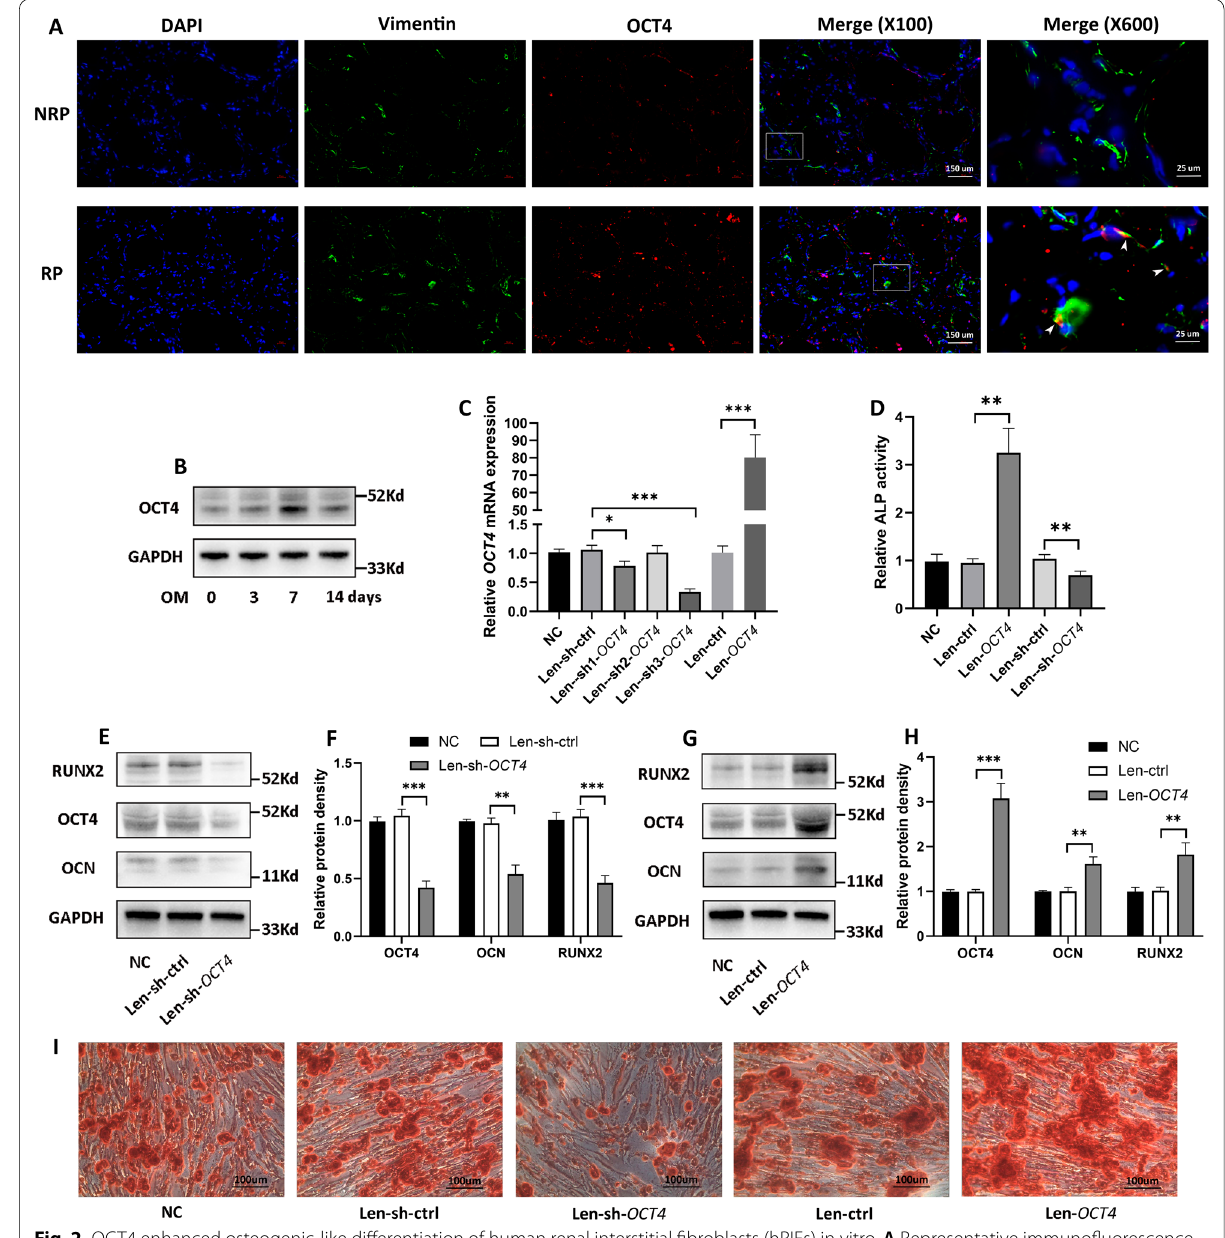
Fig. 2 OCT4 enhanced osteogenic-like differentiation of human renal interstitial fibroblasts (hRIFs) in vitro. A Representative immunofluorescence co-staining images of Vimentin (Green) and OCT4 (Red) in Randall’s plaques (RP; n 6) and normal renal papillae (NRP; n 6). B Immunoblotting (IB) = = analysis of OCT4 in hRIFs 0, 3, 7, and 14 days after osteogenic medium (OM) induction (n 3). C HRIFs were transfected with recombinant lentivirus = to overexpress or silence OCT4 , and qRT-PCR determined the efficiency (n 3). Len-sh3- OCT4 was selected for silencing OCT4 in the following = experiments because of the highest efficiency. D Alkaline phosphatase (ALP) activity in cell lysis of transfected hRIFs 7 days after osteogenic induction (n 3). E, F IB analysis of OCT4, RUNX2, and OCN in OCT4 silenced hRIFs 7 days after osteogenic induction (n 3). G, H IB analysis of = = OCT4, RUNX2, and OCN in OCT4 overexpressed hRIFs 7 days after osteogenic induction (n 3). I Alizarin Red Staining (ARS) for calcium nodes in = transfected hRIFs 14 days after osteogenic induction (n =